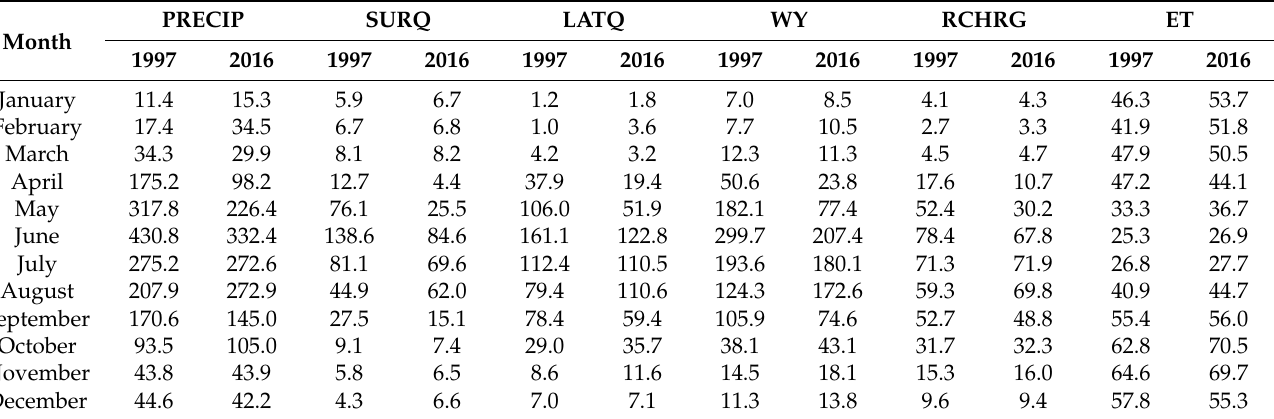
Table 8. Monthly average changes of PRECIP, SURQ, LATQ, WY, RCHRG, and ET from LU